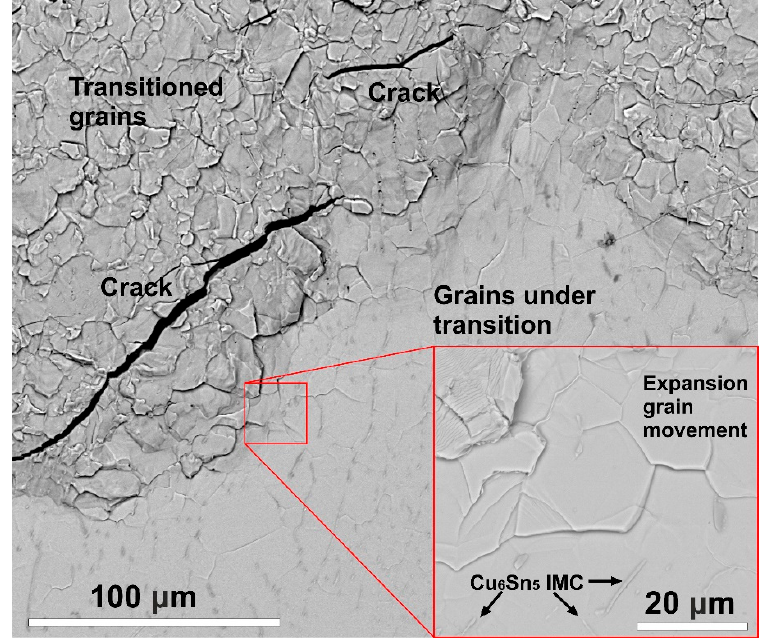
Figure 7. Scanning Electron Microscope (SEM) micrograph showing the different states of allotropic transition below the surface of a reference sample inoculated with InSb and stored at − 10 °C for 100 days.